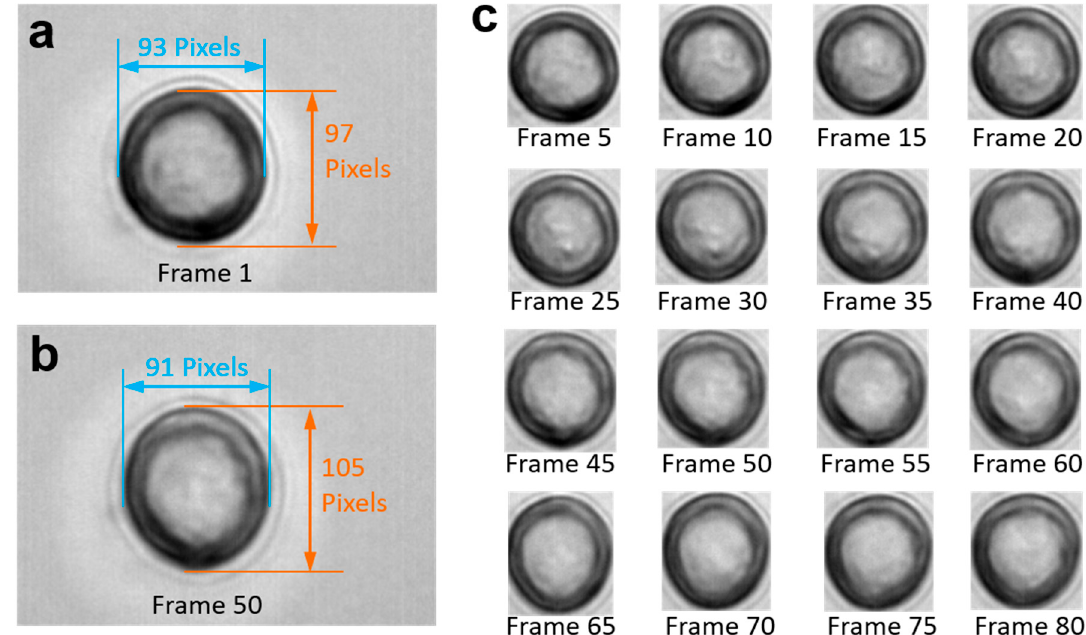
Figure 1. Video frames of rotating cells with cell image details and time-lapse image capture sequence. ( a ) Image of the original gesture of the cell. The length of the major axis is 97 pixels, while that of the minor one is 93 pixels; ( b ) after rotation, the major and minor axis lengths of the cell change to 105 and 91 pixels respectively; and ( c ) image sequence of the region of interest. The video was taken at 100 frames per second.